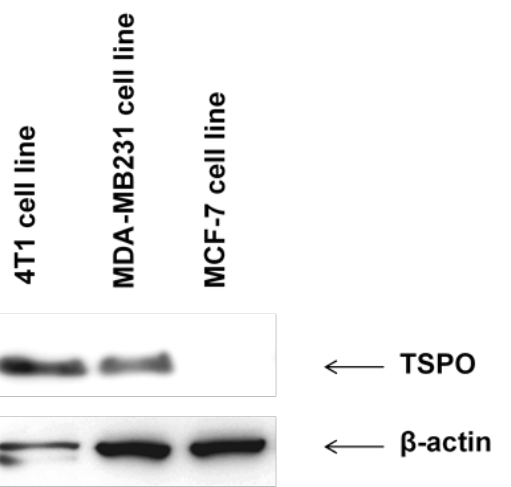
Figure 10. Western blot of TSPO expression in three cell lines of breast cancer (4T1, MDA-MB231, and MCF7).